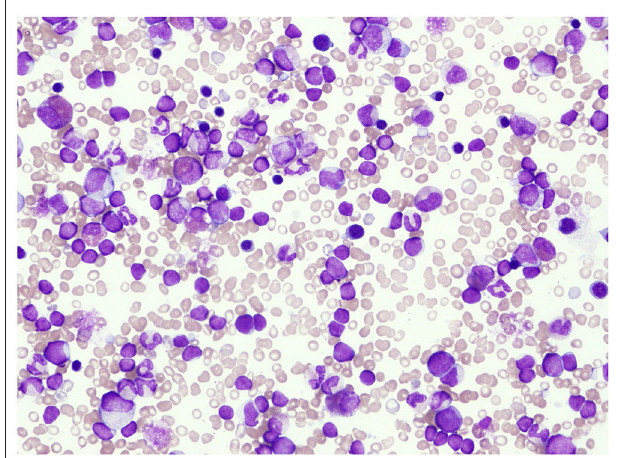
FIGURE 1 | Bone marrow examination showed a decrease in mature granulocytes and slight myeloperoxidase stain-negative blast cells but no monoclonal cell proliferation with May–Giemsa